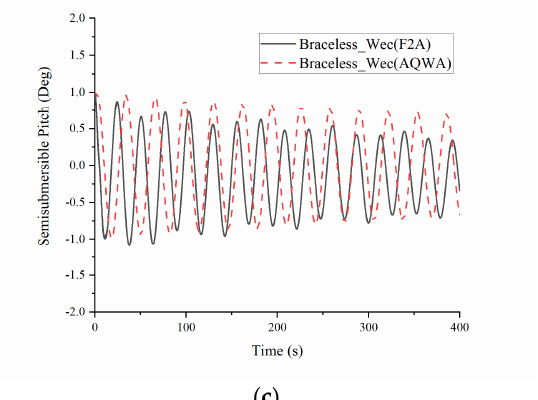
Figure 4. Time domain curve of free decay test of the semisubmersible platform: ( a ) Surge; ( b ) Heave; ( c ) Pitch.